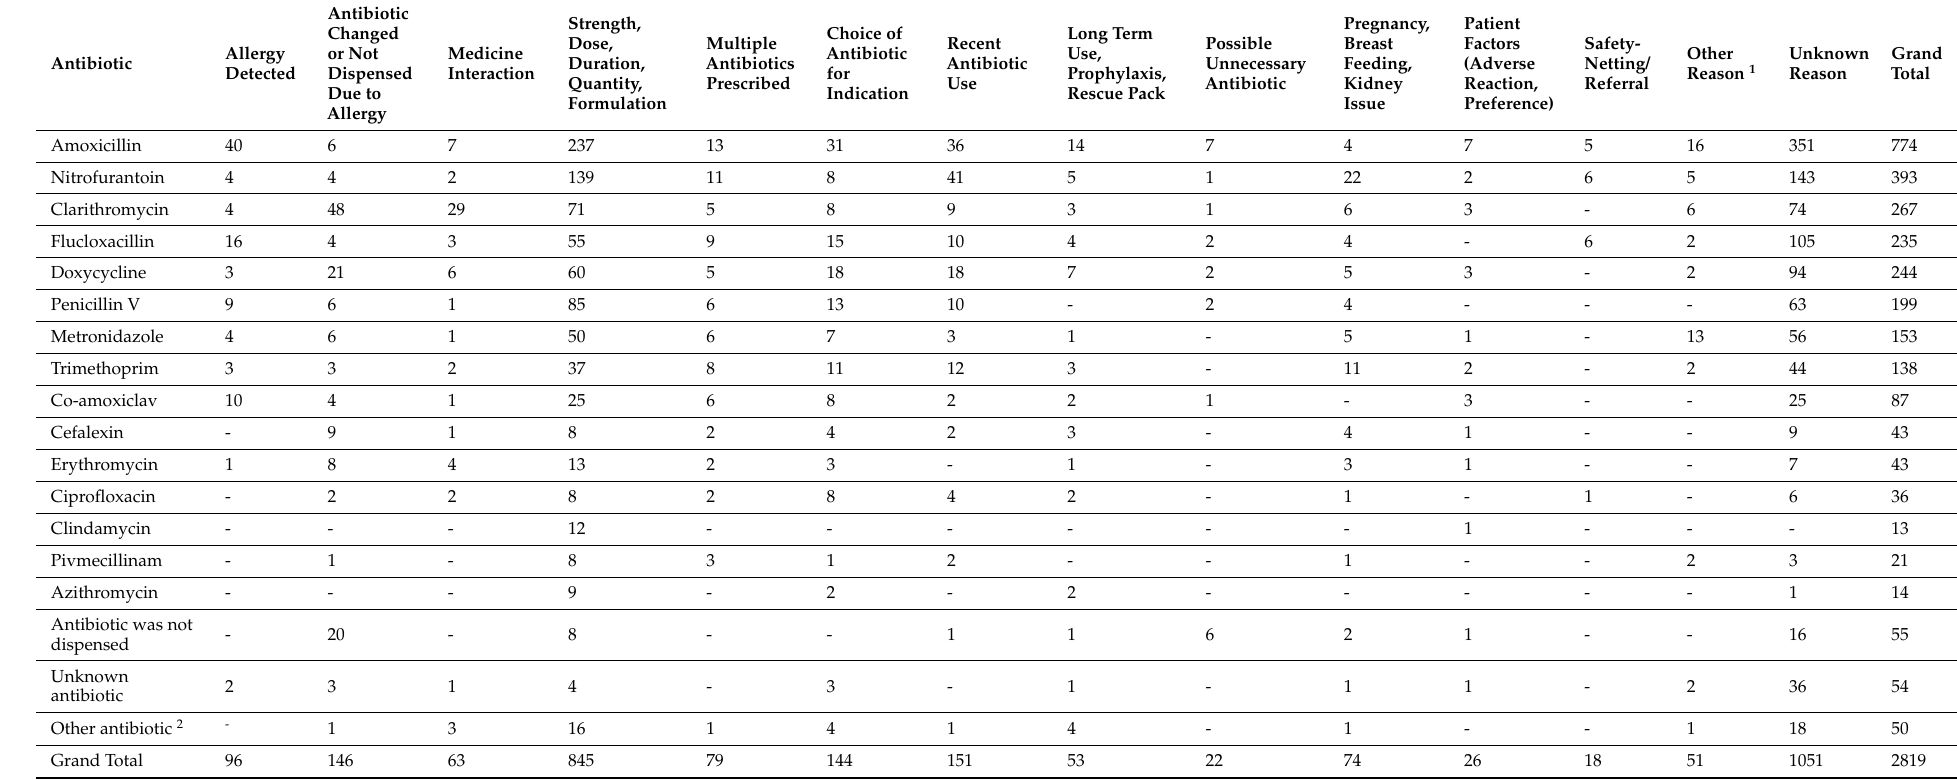
Table 3. Reasons that pharmacy teams intervened on a prescription to contact the prescribing clinician by antibiotic dispensed. The table includes all antibiotics that were recorded on the TARGET Antibiotic Checklist for interventions, including where multiple antibiotics were dispensed, or no antibiotic was dispensed. 1 Other reasons included stock availability or omission of information from the prescription. 2 ‘Other’ antibiotics were queried less than five times each: levofloxacin, Sofradex, fosfomycin, co-trimoxazole, methenamine hippurate, vancomycin, itraconazole, neomycin, fusidic acid, gentamycin, co-fluampicil, linezolid, rifampicin, cefuroxime, tetracycline, fusidic acid cream,